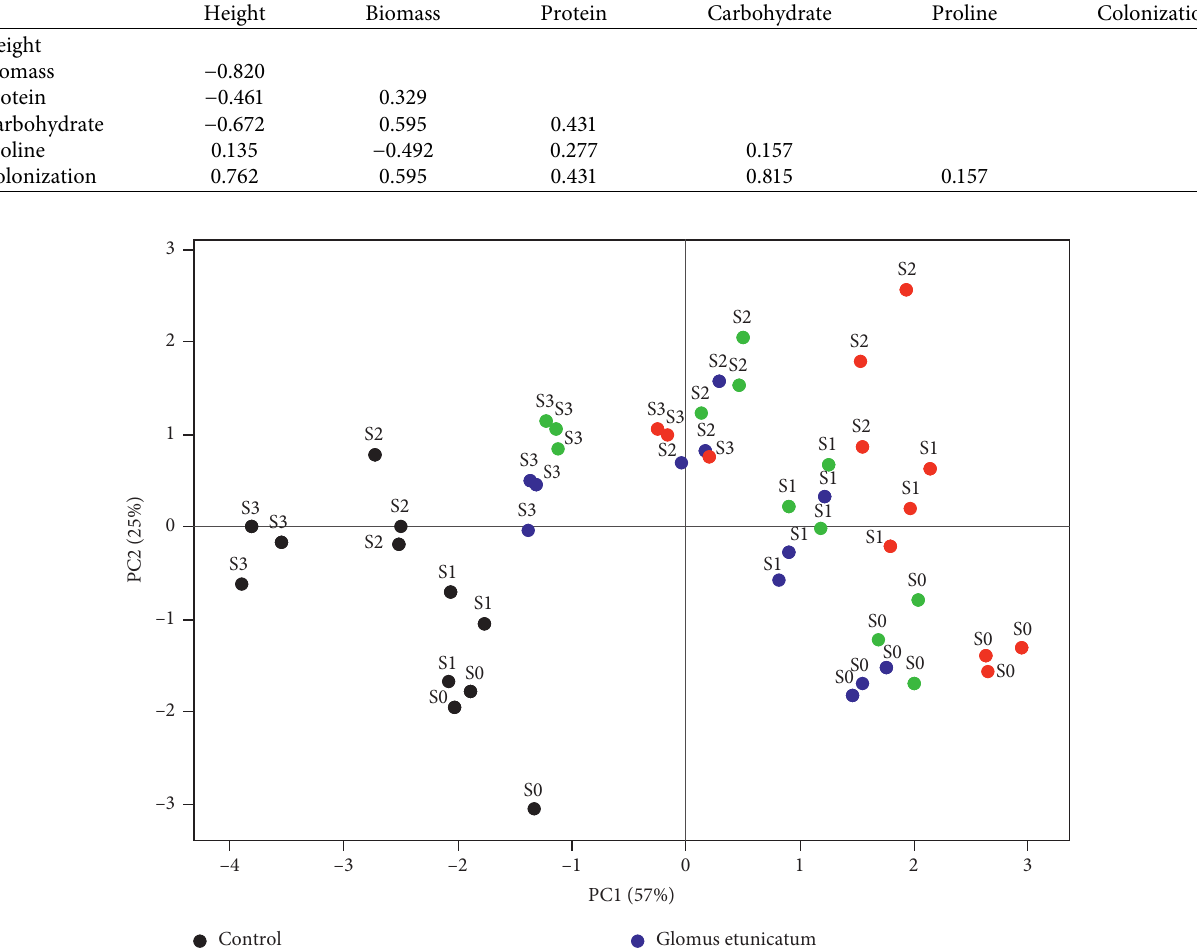
Table 1: Pearson’s correlation matrix ( r ) of all morphological and physiological parameters.